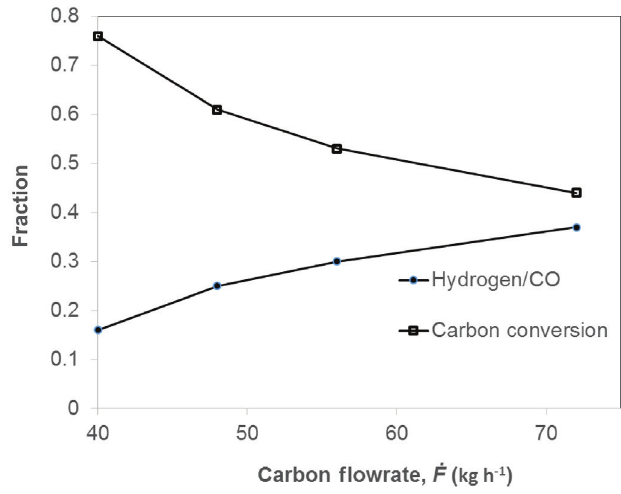
Fig. 6 – Effect of carbon flowrate on syngas quality and car- bon